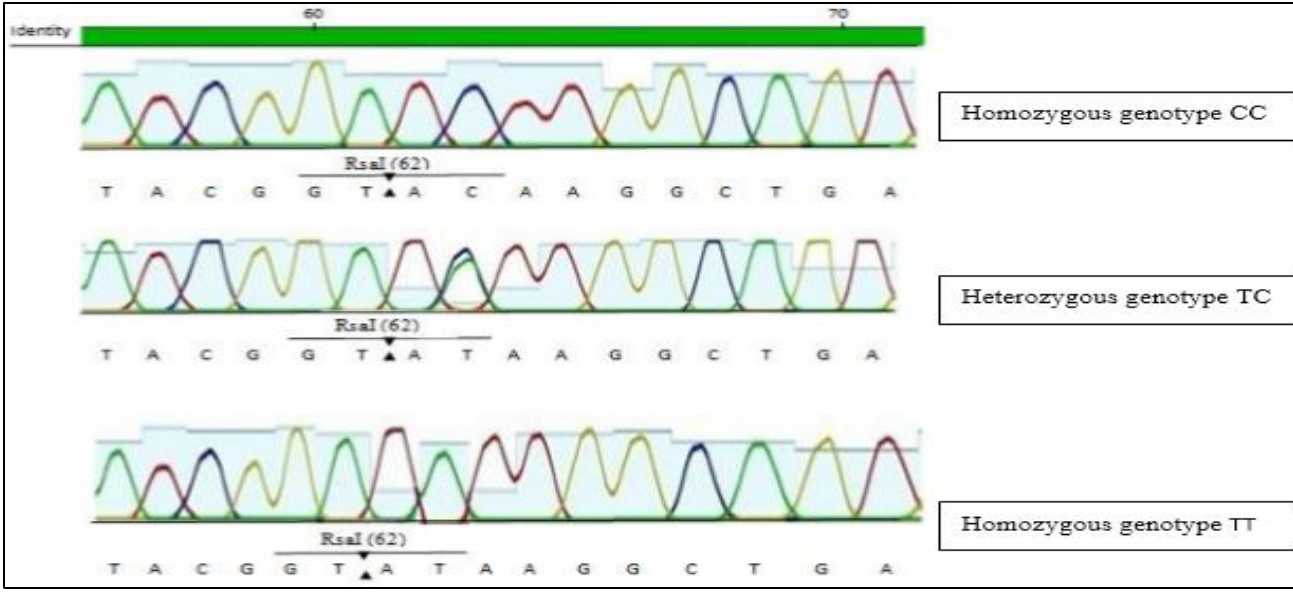
Figure 4. Sequence analysis of the TGF- β2 gene populations and sub-populations (27). Gene flow across boundaries introduces new unique alleles in a population, leading to an increase in heterozygosity for the whole population (27). It was reported that chickens had two alleles (T and C) and three genotype variants (TT, CT, and CC) for the TGF- β2 gene (21). Polymorphic Indonesian chickens with two alleles (T and C) and three genotypes (TT, CT, and CC) were seen by (23). At the same time, the T allele had a higher prevalence than the C allele in Indonesian chickens owing to inbreeding and vigorous selection of the TGF- β2 gene. Table 2 . Distribution of genotype and allele frequency TGF- β2